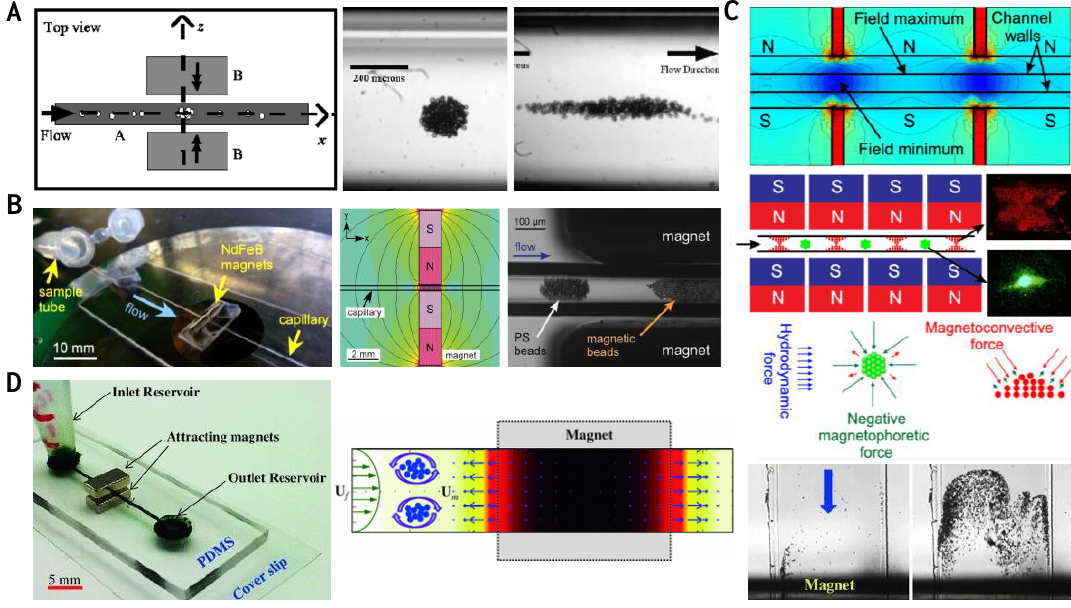
Figure 8. Diamagnetic particle trapping and enrichment in the flow of magnetic fluids under the magnetic field of a pair of permanent magnets. ( A ) Top-view schematic of the particle trapping region between two repulsing magnets (left); self-assembled sphere (middle) and ellipsoid (right) of 21 µm diameter PS beads in 0.005% ferrofluid using two opposing cylindrical and rectangular magnets, respectively. Adapted with permission from Feinstein and Prentiss [104], © 2006 American Institute of Physics. ( B ) Picture of the diamagnetic particle trapping setup (left) and simulated magnetic field of two attracting magnets (middle); simultaneous formation of a plug of 8 µm magnetic beads between the magnets and a plug of 10 µm diamagnetic beads before the magnet pair (right). Adapted with permission from Tarn et al. [105], © 2013 The Royal Society of Chemistry. ( C ) Simulated magnetic field illustrating the concept of magnetofluidic concentration of particles (top); schematic and demonstration of the size-selective traps for diamagnetic large green and small red beads (middle) with a schematic description of the dominant forces (bottom). Adapted with permission from Hejazian and Nguyen [106], © 2016 American Institute of Physics. ( D ) Picture of the microfluidic device sandwiched between two attracting magnets (left) and illustration of the diamagnetic particle trapping mechanism (middle); snapshot images showing the magnetic enrichment of 5 µm PS beads in 0.05 × EMG 408 ferrofluid at 5 s and 5 min after the flow was switched on (right). Adapted with permission from Zeng et al. [107], © 2013 Springer.